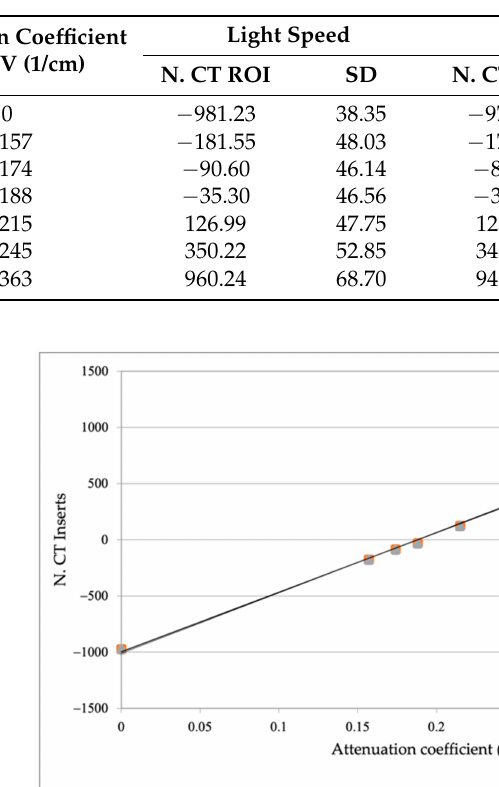
Table 2. Average CT values for the three types of equipment.